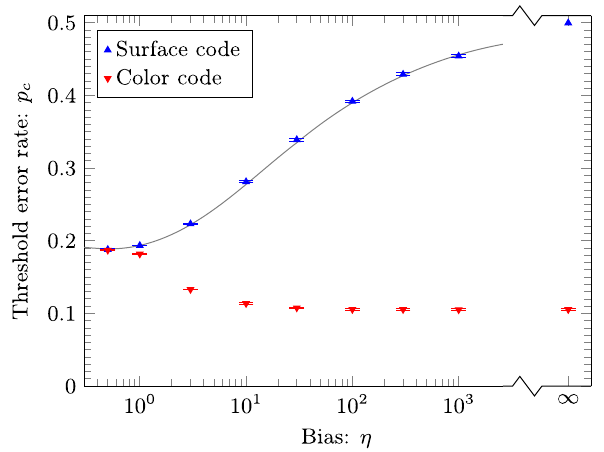
FIG. 19. Threshold error rate p as a function of bias η . Red c inverted triangles show threshold estimates for the triangular 6.6.6 color code. For comparison, blue triangles show threshold estimates for the surface code (reproduced from Sec. VA), with the point at infinite bias, i.e., only Y errors, indicating the analytically proven 50% threshold. Error bars indicate one standard deviation relative to the fitting procedure. The gray line is the hashing bound for the associated Pauli error